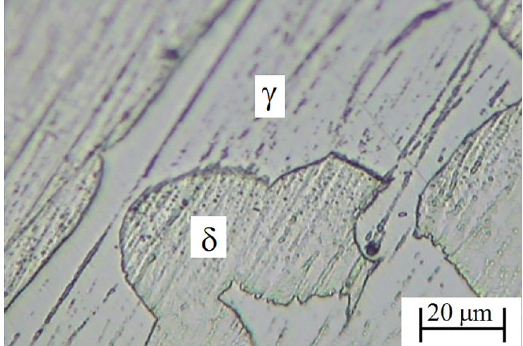
Figure 11. Microstructure obtained after portable DL-EPR test performed at room temperature in SD-B material aged at 800ºC for 15 minutes.